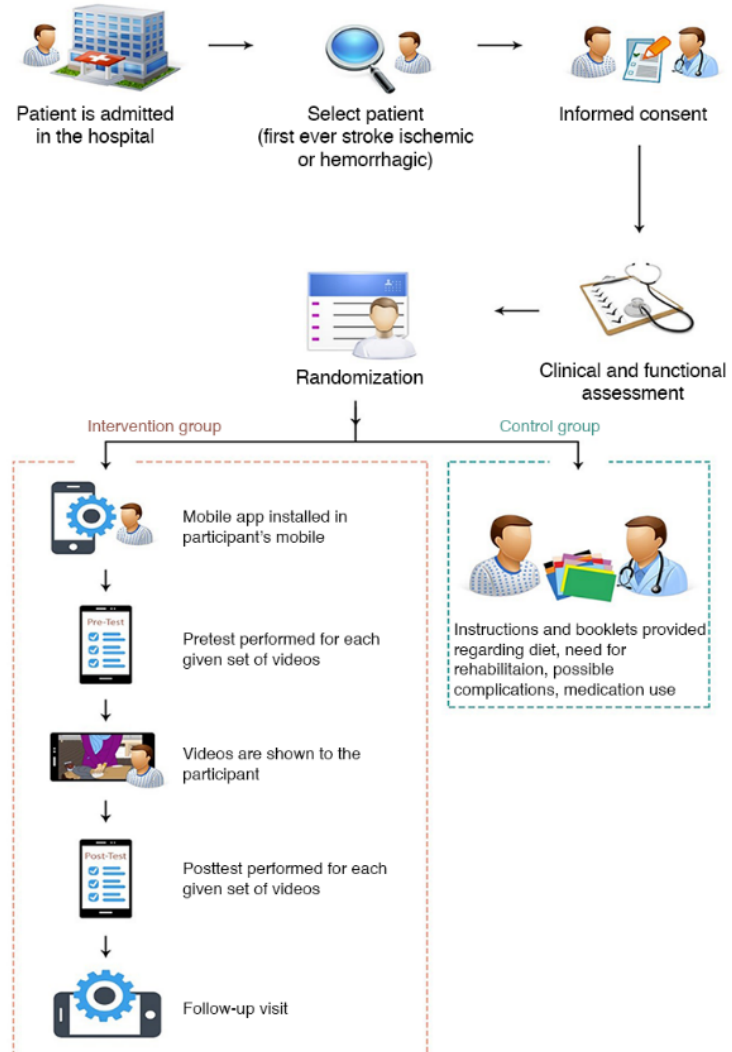
Figure 2. Study flow (enrollment to